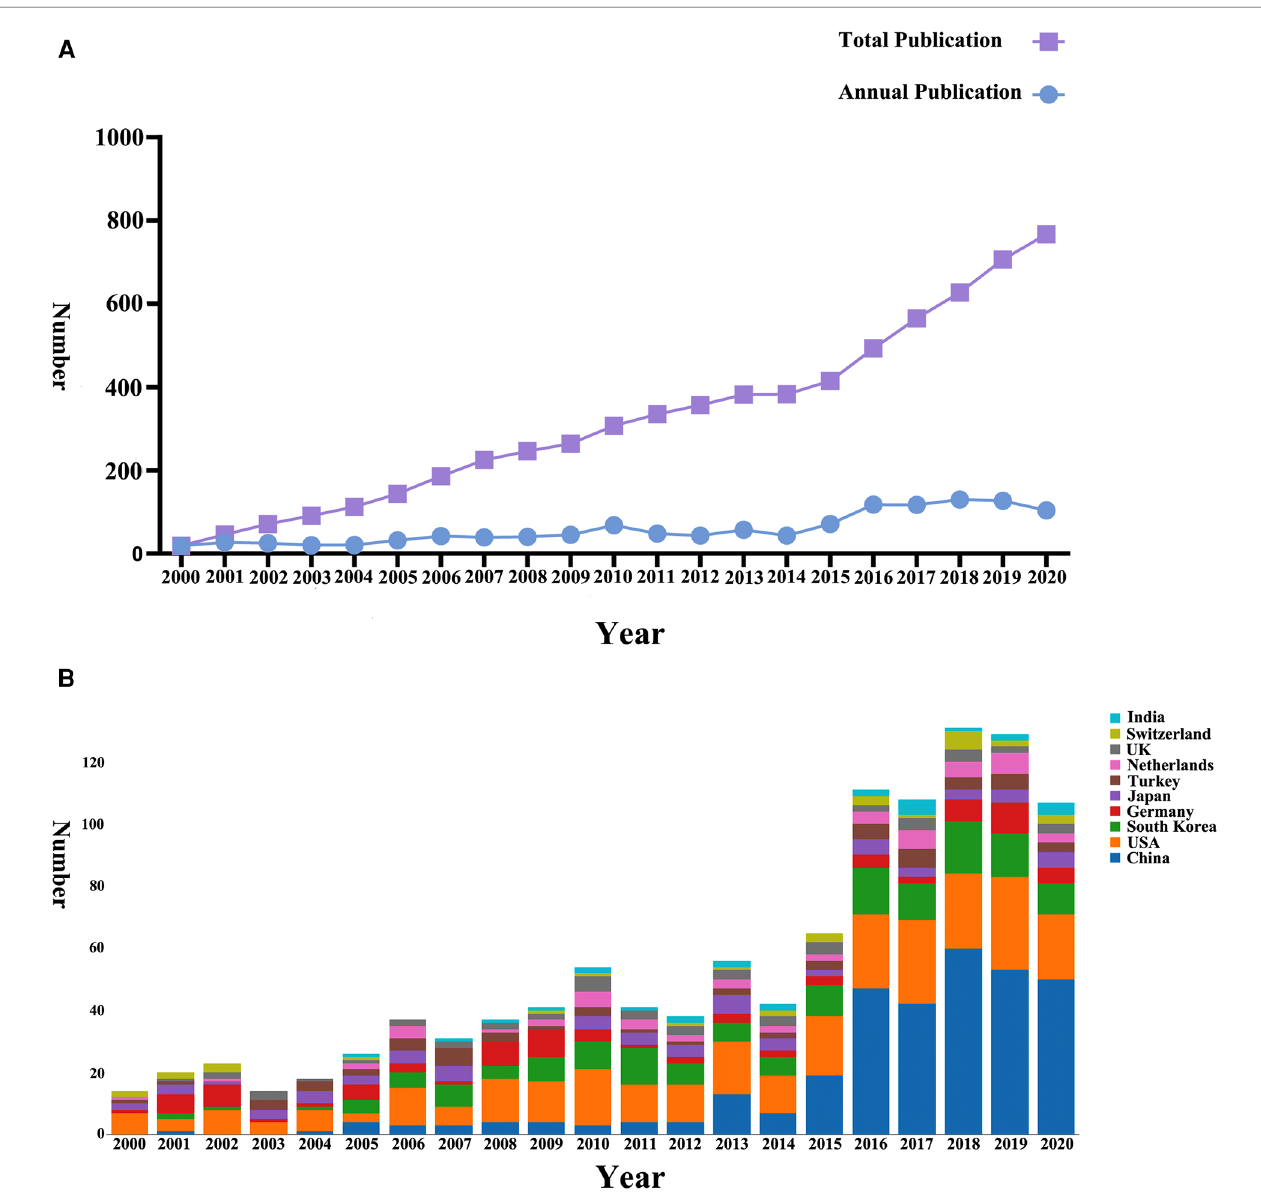
FIGURE 1 Global trends in research on discectomy from 2000 to 2020. ( A ) The number of publications on discectomy worldwide. ( B ) The number of publications on discectomy worldwide classi fi ed by